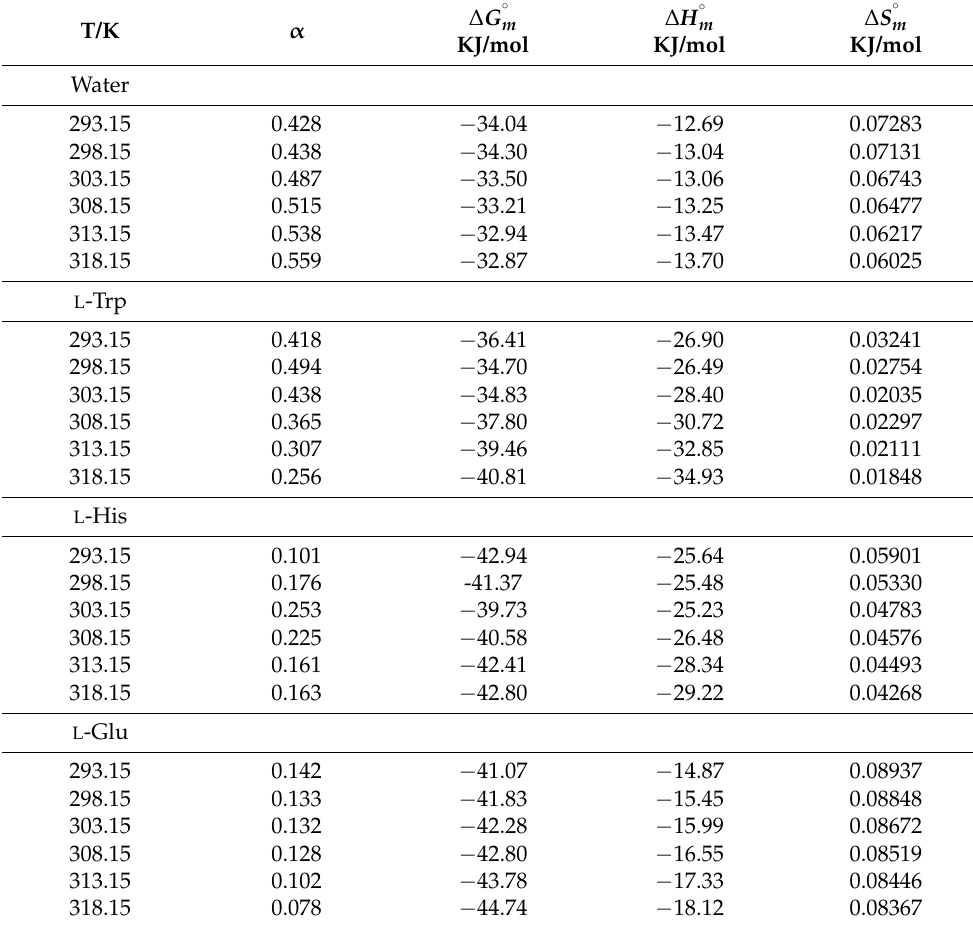
Table 3. Thermodynamic parameters of SDS micellization in the absence and presence of 0.01 M amino acid at different